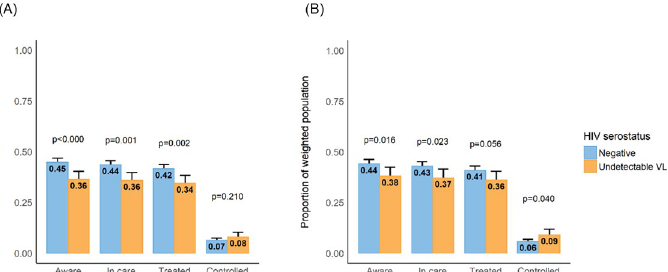
Fig 1. The cascade of diabetes care among HIV negative versus HIV positive/successful ART adults in uMkhanyakude, KwaZulu-Natal, South Africa, according to HIV/ART status. A. Minimally adjusted diabetes care cascade. � Estimates adjusted for age and sex only and include inverse probability of sampling weights. B. Fully adjusted diabetes care cascade. � Estimates adjusted for age, sex, BMI, wealth tertile, education and smoking status, and include inverse probability of sampling weights.